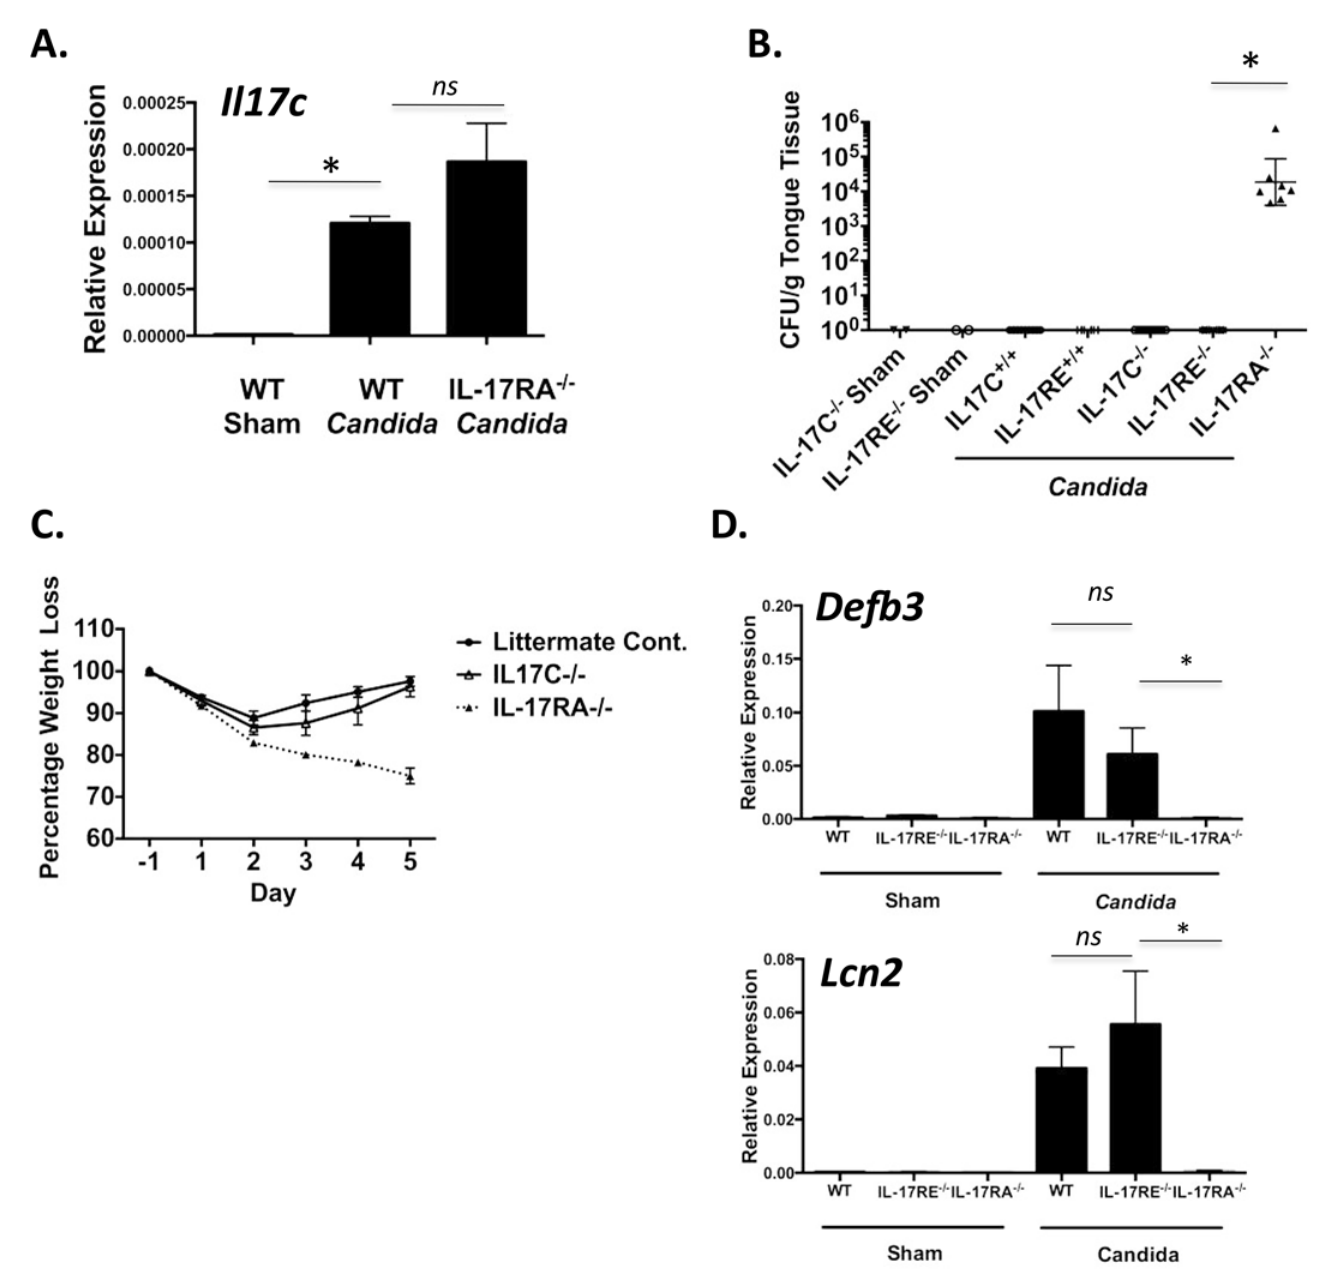
Fig 1. IL-17C -/- and IL-17RE -/- mice are resistant to oropharyngeal candidiasis. A. WT and IL-17RA -/- mice (n = 3 per group) were subjected to OPC and IL-17C transcript levels assessed by qPCR. * p < 0.05 with error bars indicating SEM. B. OPC was induced in the indicated mice (IL-17C -/- Sham, n = 2; IL- 17RE -/- Sham, n = 2; Infected: IL-17C +/+ n = 9; IL-17RE +/+ , n = 6; IL-17C -/- , n = 9; IL-17RE -/- , n = 6; IL-17RA -/- n = 7). Tongue was harvested on day 5, and CFU enumerated 48 h later by plating serial dilutions on YPD agar. Data presented as the geometric mean of CFU. Each data point represents one mouse, and the graph depicts pooled data from two independent experiments (n = 2 for each sham-infected cohort and n (cid:1) 6 total for each Candida-infected cohort). * p < 0.0001 by Mann Whitney U test. C. Weight loss was assessed daily and is presented as a percentage of starting weight. Error bars indicate SEM. D. Indicated mice (n = 3 per group) were subjected to OPC and qPCR performed for Defb3 and Lcn2 genes on day 2. * p < 0.05 by ANOVA and post-hoc Tukey ’ s test. Error bars indicate